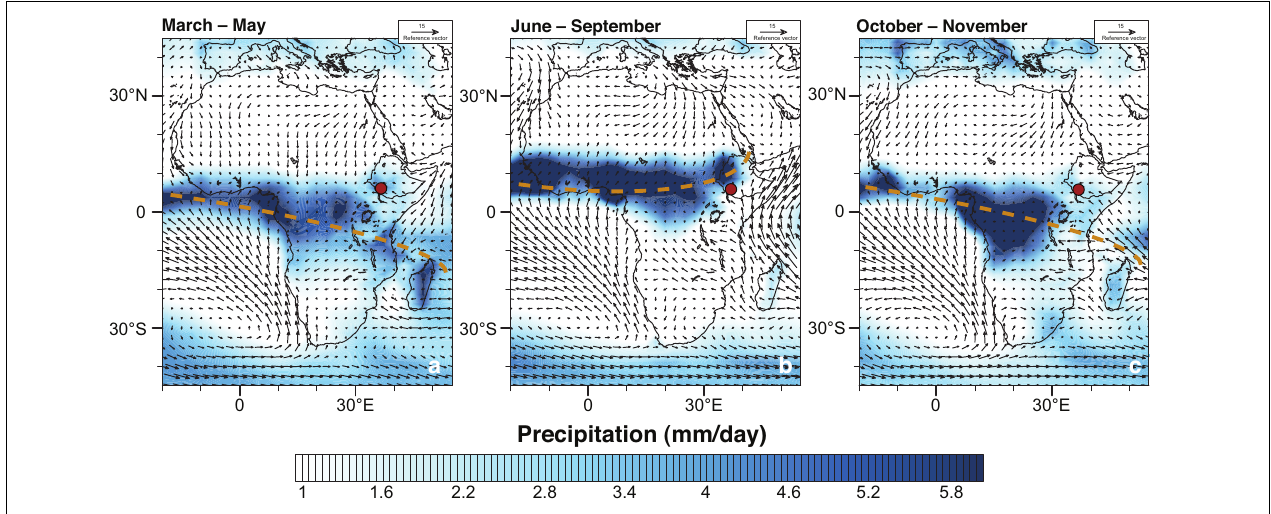
FIGURE 2 | Seasonal precipitation (mm/day) patterns in eastern Africa during (a) March–May, (b) June–September, and (c) October–November; mean precipitation for the period 1979–2015 at 1,000 hPa geopotential height (gph) fields. Global Precipitation Climatology Centre (GPCC) monthly precipitation data is acquired from the National Oceanic and Atmospheric Administration (NOAA) and can be accessed at https://www.esrl.noaa.gov/psd/. Thick, dashed, brown lines indicate the approximate location of the tropical African rain belt. Red circle indicates the location of the drill site.